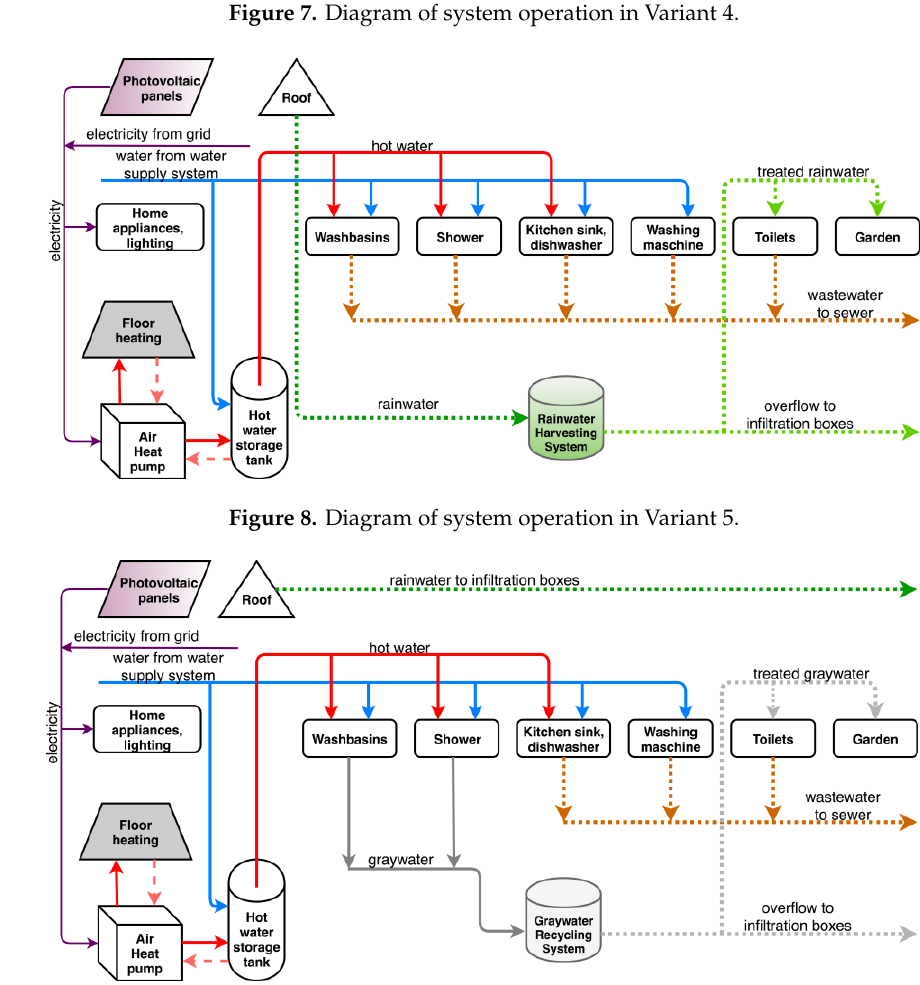
Figure 9. Diagram of system operation in Variant 6.